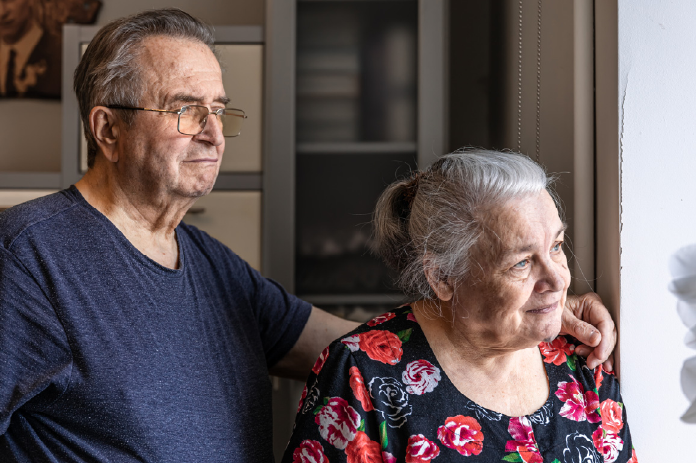
Figure 1. Couple of older persons. Source, Freepik. https://www.freepik.es/foto-gratis/linda-pareja-